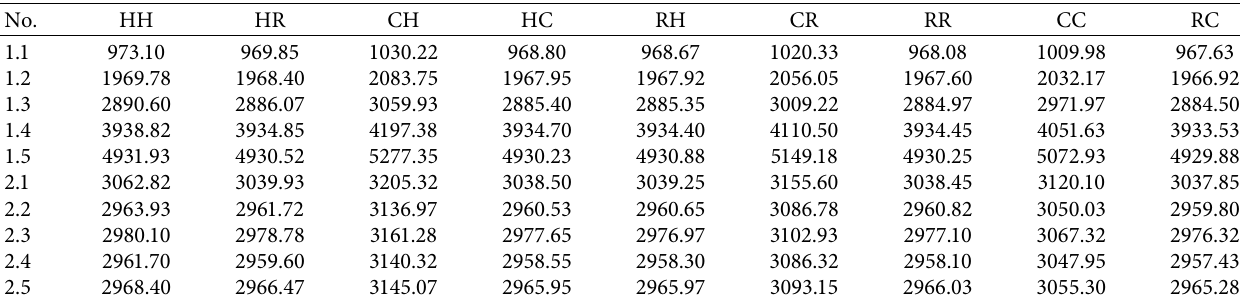
Table 16: Mean lengths of schedules returned by the LS algorithms for the benchmark given in [9] with cov �